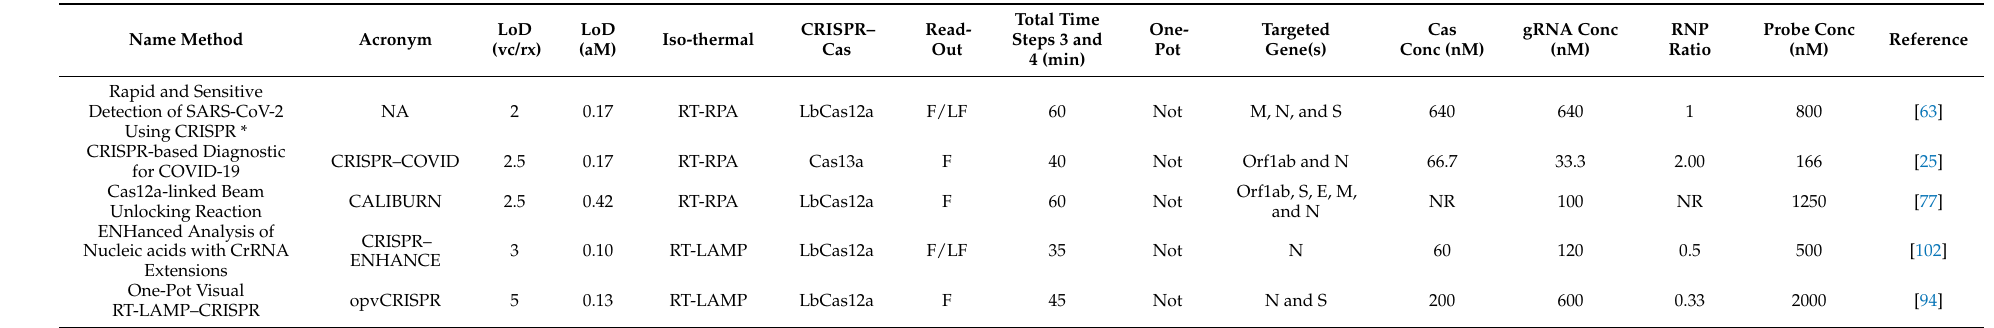
Table 4. List of CRISPR-based methods with the lowest limit of detection